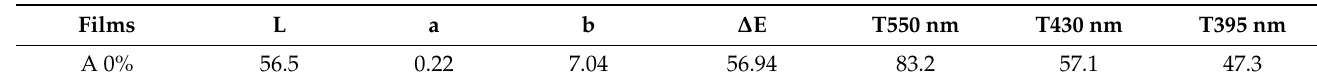
Table 5. Measured of color apparent and transmittance light transmittance of prepared nano edible coating & films combined with ZnONPs and ZnONPs/EPP to produce edible films using scanning electron microscopy (SEM) technology.